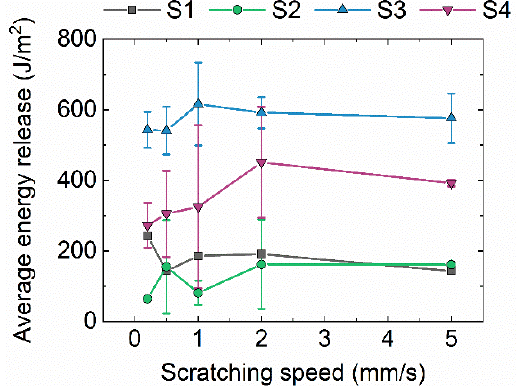
Figure 6. Calculated energy release as a function of the scratching speed, for the different types of samples.